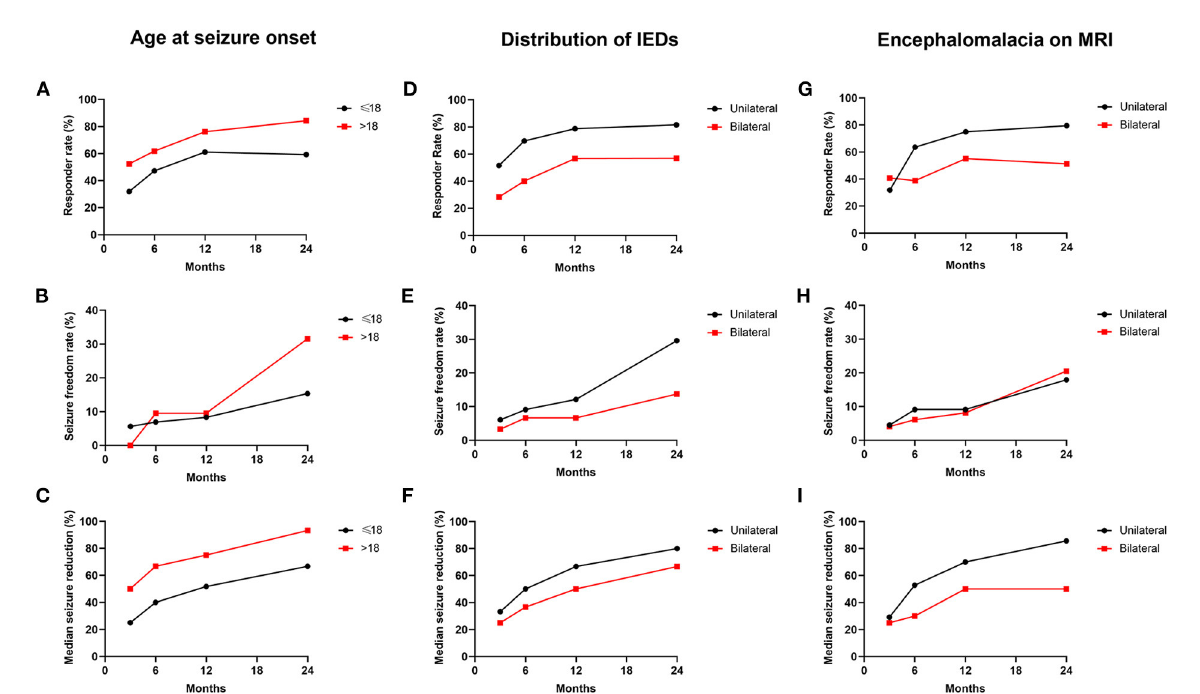
FIGURE4 Seizure outcomes in patients classified by predictors of VNS effectiveness. (A–C) The responder rate (A) , seizure freedom rate (B) , and median seizure reduction (C) according to the classification of the age at seizure onset. (D–F) The responder rate (D) , seizure freedom rate (E) , and median seizure reduction (F) according to the classification of the distribution of IEDs. (G–I) The responder rate (G) , seizure freedom rate (H) , and median seizure reduction (I) according to the classification of the distribution of encephalomalacia on MRI.